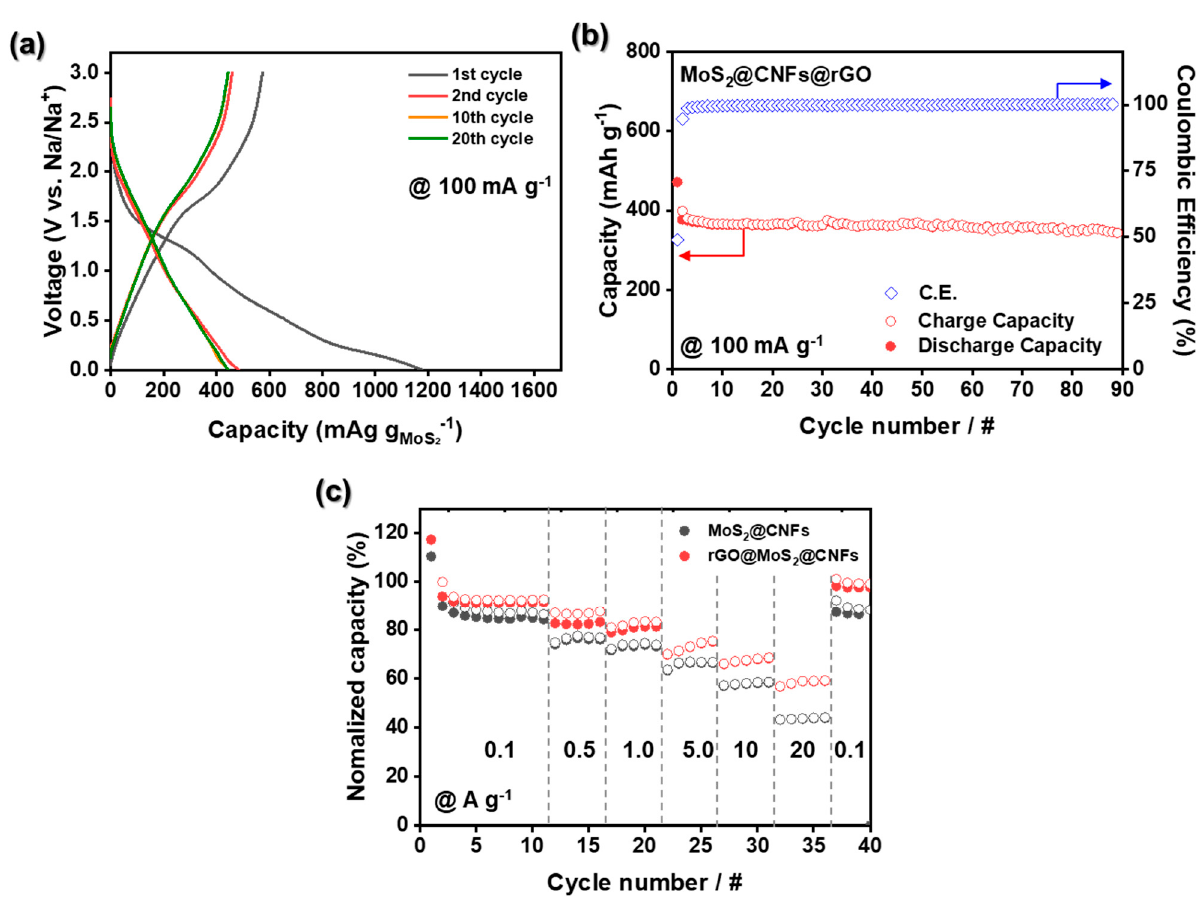
Figure 6. Electrochemical performances of MoS 2 @CNFs@rGO. ( a ) Charge–discharge profile at 100 mA g − 1 between 0.005 V~3.0 V vs. Na/Na + . ( b ) Cycling performance at 100 mA g − 1 . ( c ) Rate capability with different current densities (0.1~20 A g − 1 ).